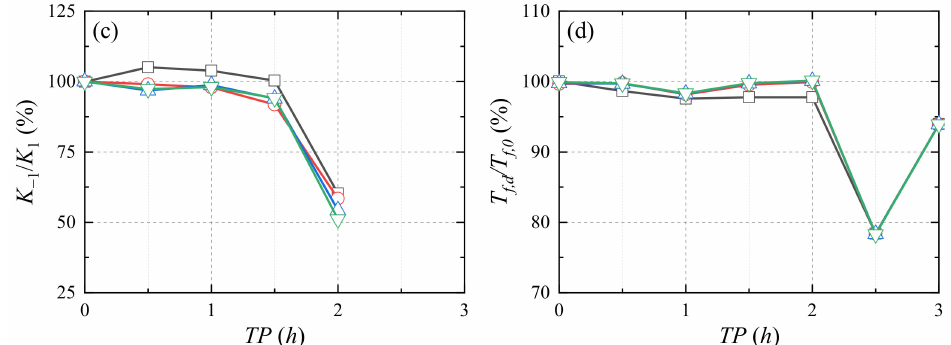
Figure 18. Impact of cyclic loads with different number of cycles ( Noc ) on the response of RC column during fire exposure: ( a ) cyclic load effect coefficient η ; ( b ) MAPE ; ( c ) stiffness degradation ratio; ( d ) fire resistance time ratio.